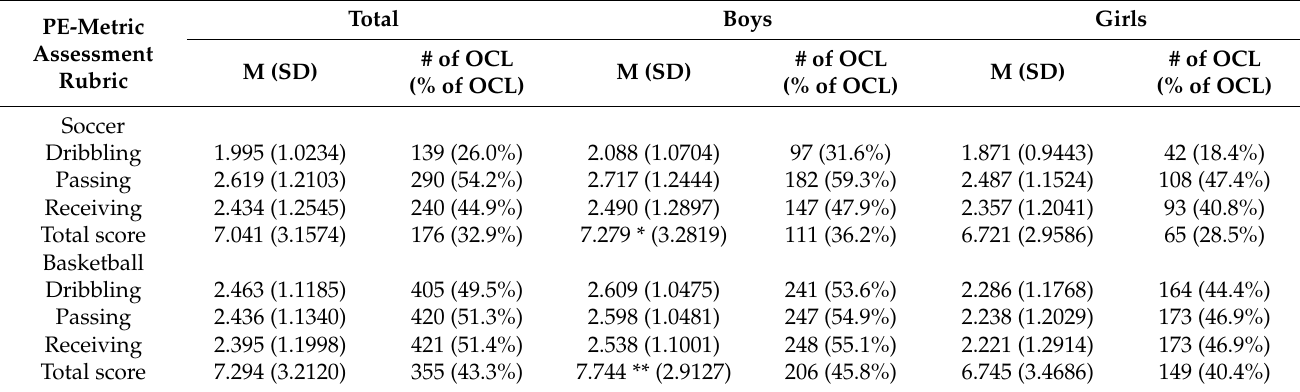
Table 3. Descriptive statistics of the manipulative skill assessments for total sample and by